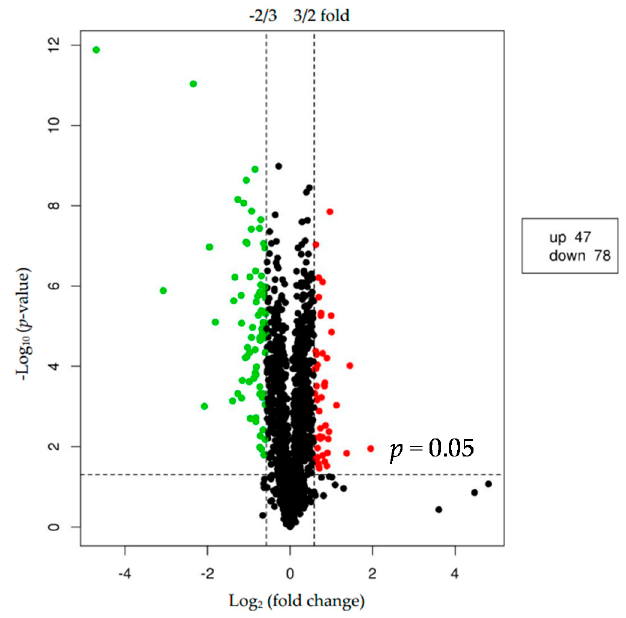
Figure 2. Volcano plot showing proteins differentially expressed between the two groups of abalone (larger and smaller). The upregulated and downregulated proteins ( p < 0.05 for both) are shown in red and green, respectively. Black represents no significant change in expression level.